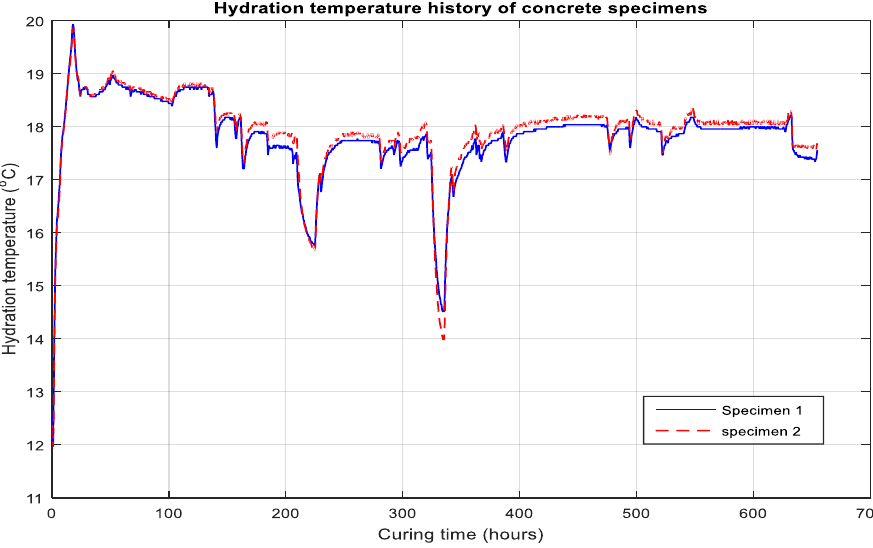
Figure 8. Hydration temperature for concrete specimens 1 and 2.